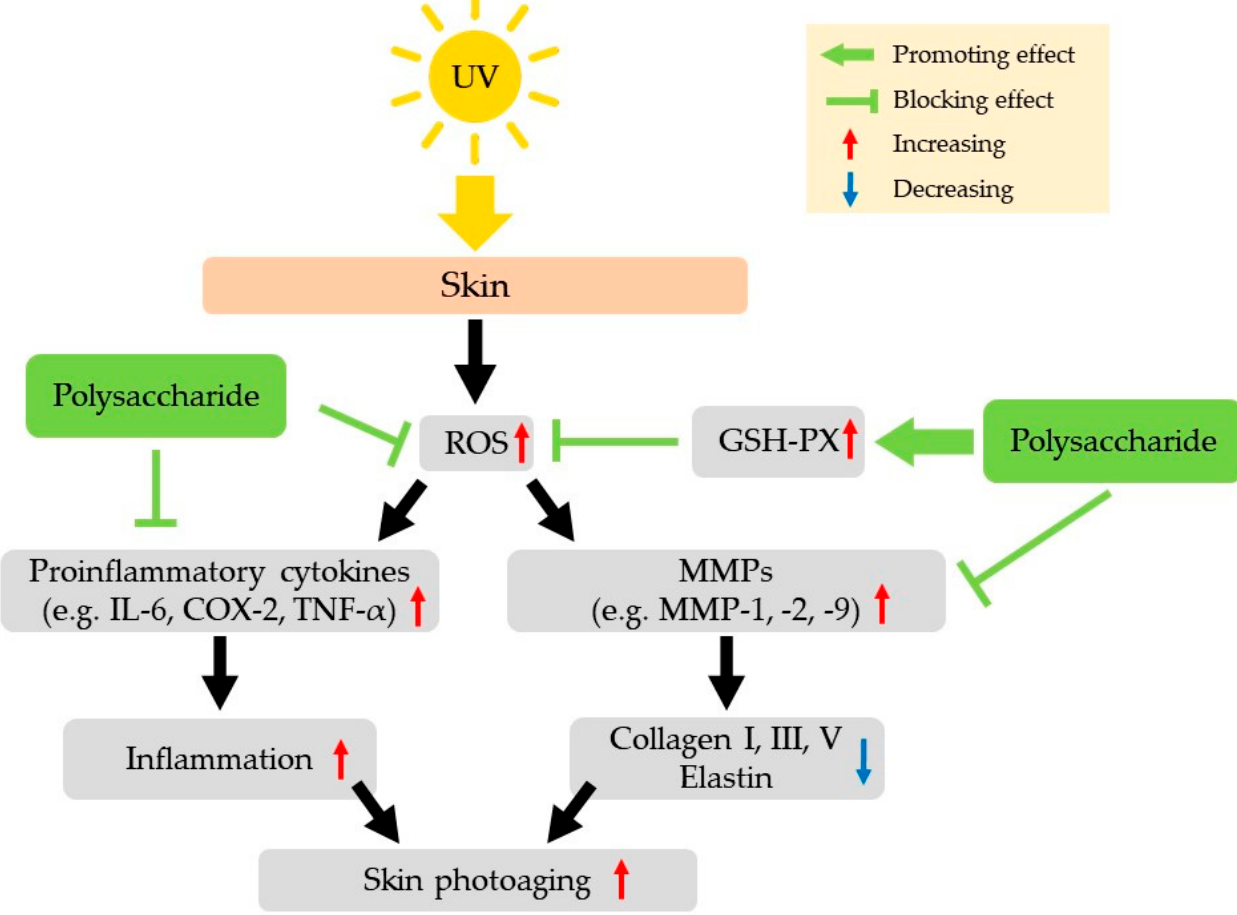
Figure 1. The schematic diagram of UV irradiation-induced skin aging and polysaccharides acting for skin protection.